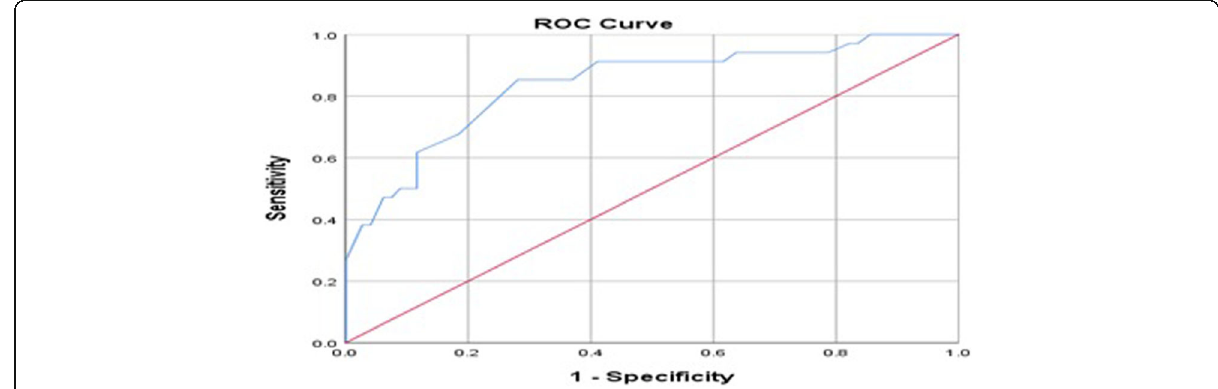
Fig. 1 ROC denoting the best cut-off value of LSM, which fulfills the highest sensitivity and